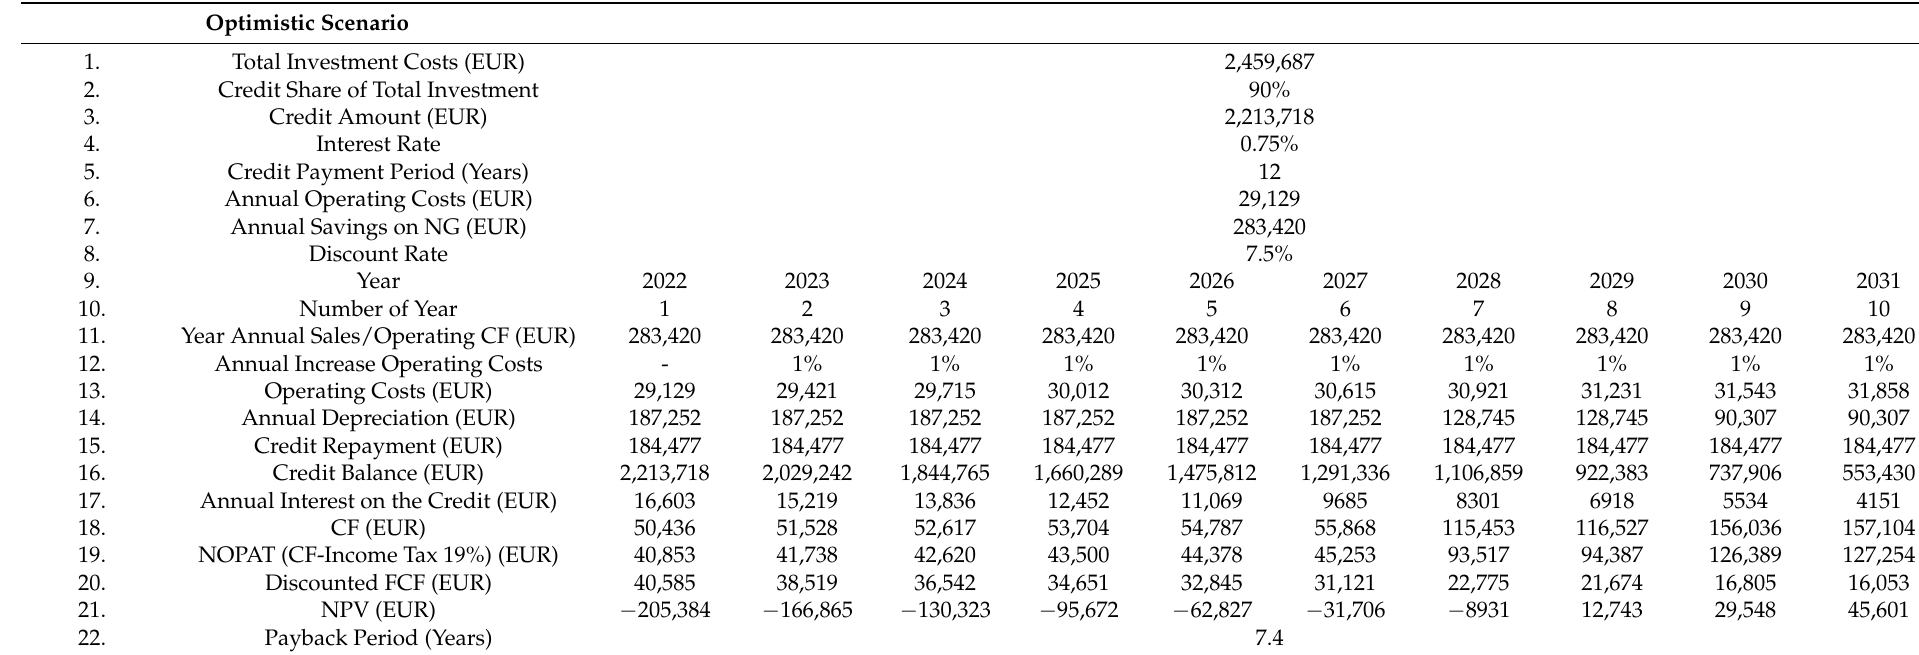
Table 7. Calculation of the evaluation of the economic efficiency of the implemented geothermal project for the optimistic